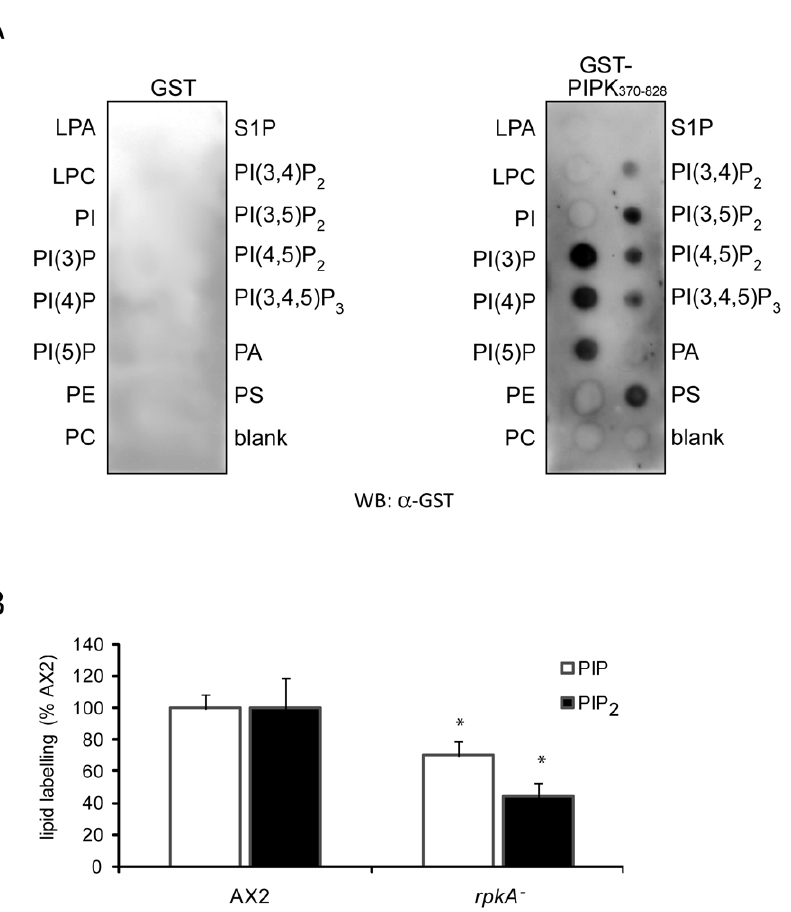
Figure 6. RpkA influences phosphoinositolphosphate turnover. (A) The PIPK 370 – 828 domain binds to phosphoinositolphosphates. PIP-Strip-membranes were incubated over night with GST-PIPK 370 – 828 (1 m g/ml) and with GST (1 m g/ml) for control. Binding was detected by incubation with polyclonal GST-antibodies. (B) Loss of RpkA leads to reduced PIP and PIP 2 levels. Phosphoinositide turnover in AX2 and rpkA 2 cells was monitored by permeabilized cells, and labeling phospholipids with [ c - 32 P] ATP. Subsequently cells were lysed, phospholipids were extracted and separated by TLC, imaged using Typhoon phosphorimager, quantified with ‘‘ImageQuant’’ and normalized according to total lipids. Results are provided for triplicate experiments with duplicate samples 6 SD, *P , 0.05.